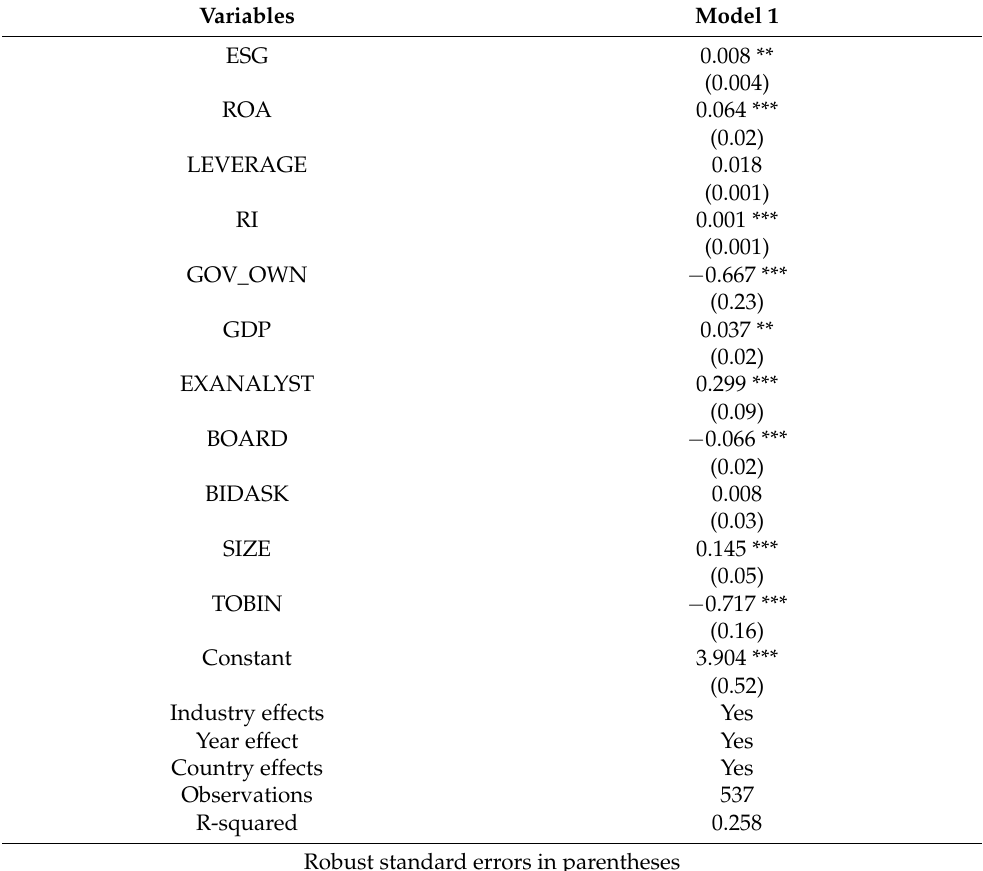
Table 6. Baseline regression for the association between ESG and